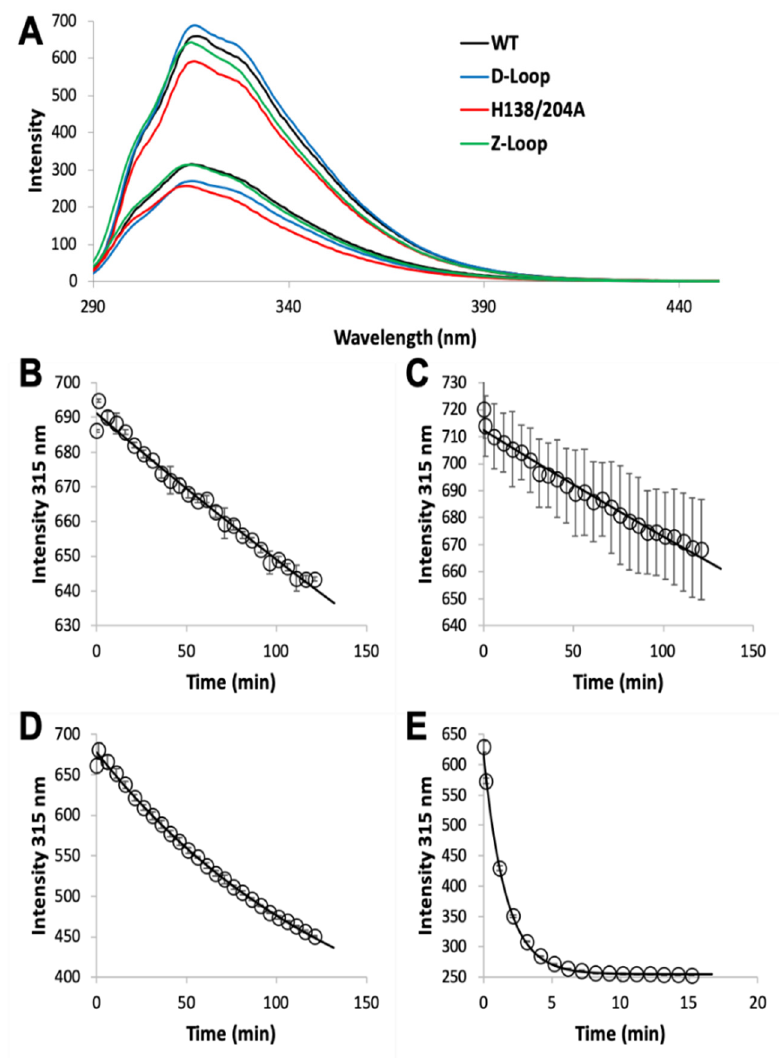
Figure 3. Zinc dissociation from WT and mutant AztC. ( A ) Fluorescence emission spectra of WT (black), ∆ D-Loop (blue), ∆ Z-Loop (green) and H138 / 204A (red) AztC before and after addition of saturating ZnCl 2 . Upon addition of excess EDTA, the emission intensity at 315 nm was tracked over time for WT ( B ), ∆ D-Loop ( C ), ∆ Z-Loop ( D ), and H138 / 204A ( E ) AztC. Dissociation experiments were performed in triplicate and error bars represent the standard deviation between measurements.